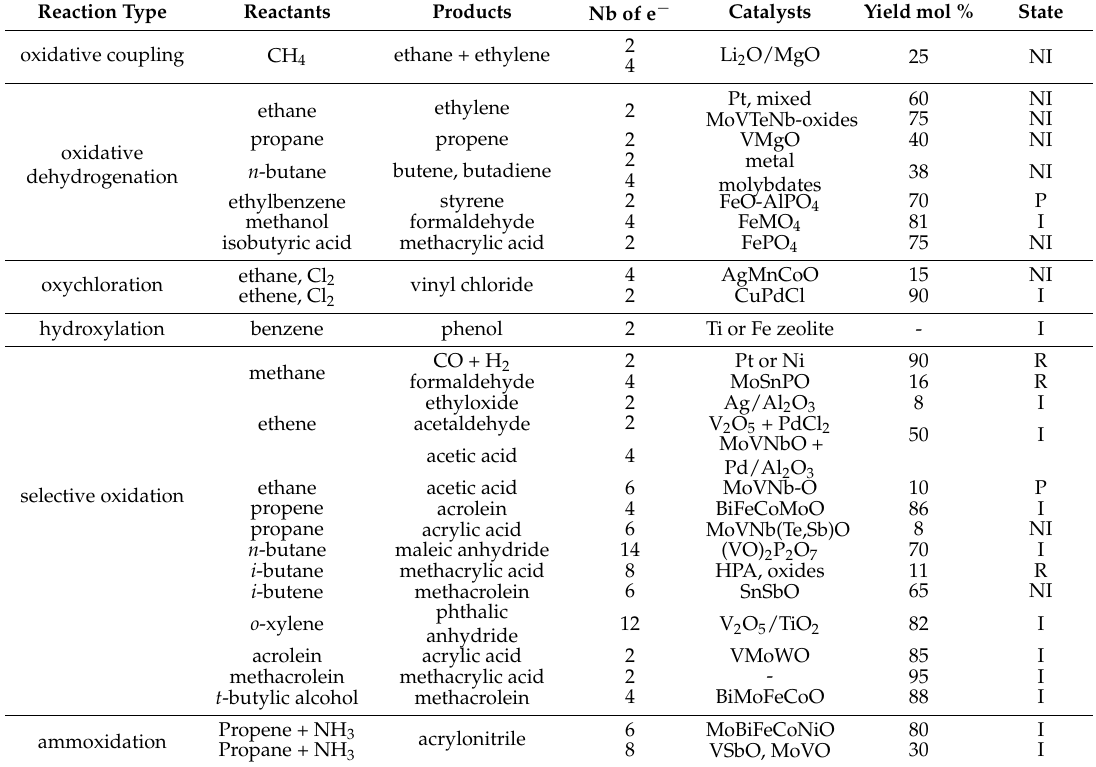
Table 1. Main selective oxidation reactions in heterogeneous catalysis from [14]. Process: NI = not industrialised yet, I: industrialised; P: pilot, R: